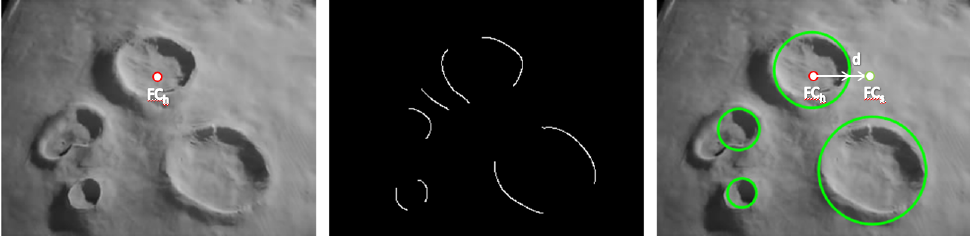
Figure 10. Image acquisition, Canny and circles detection algorithms, and the avoidance approach performed on the lunar terrain of the